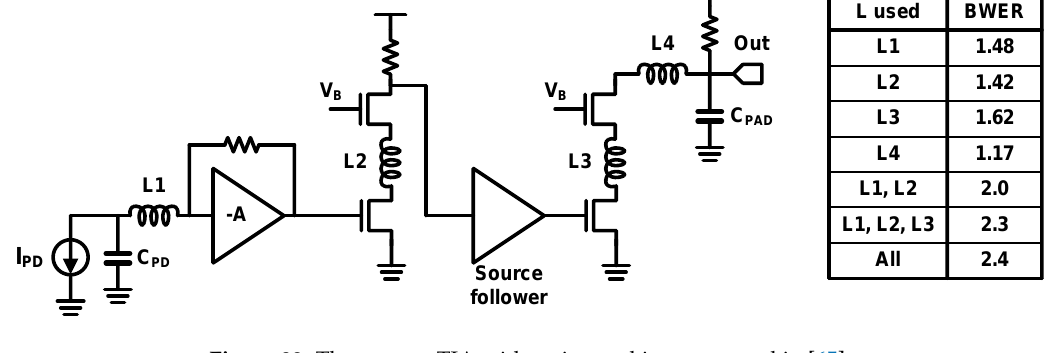
Figure 32. Three-stage TIA with series peaking presented in [65]. Sensors 2017 , 17 , 1962